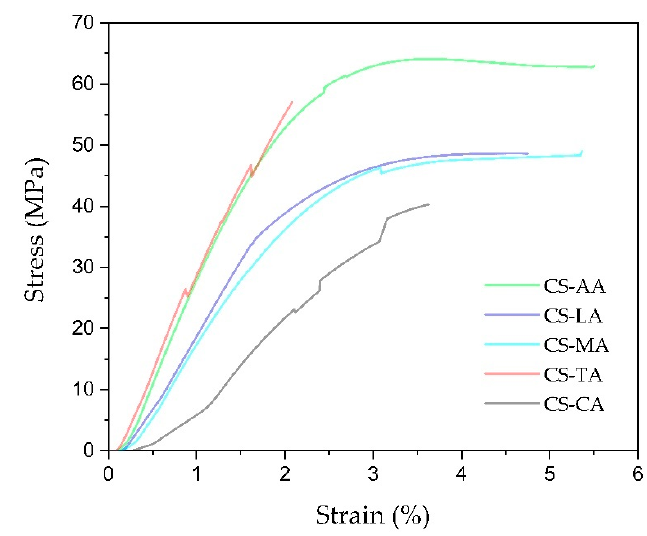
Figure 3. Stress-strain curves of shrimp chitosan films prepared with acetic, lactic, maleic, tartaric and citric acids (CS-AA, CS-LA, CS-MA, CA-TA and CS-CA, respectively). Table 3. Tensile properties of shrimp chitosan films prepared with acetic, lactic, maleic, tartaric and citric acids (CS-AA, CS-LA, CS-MA, CA-TA and CS-CA, respectively). Film Sample